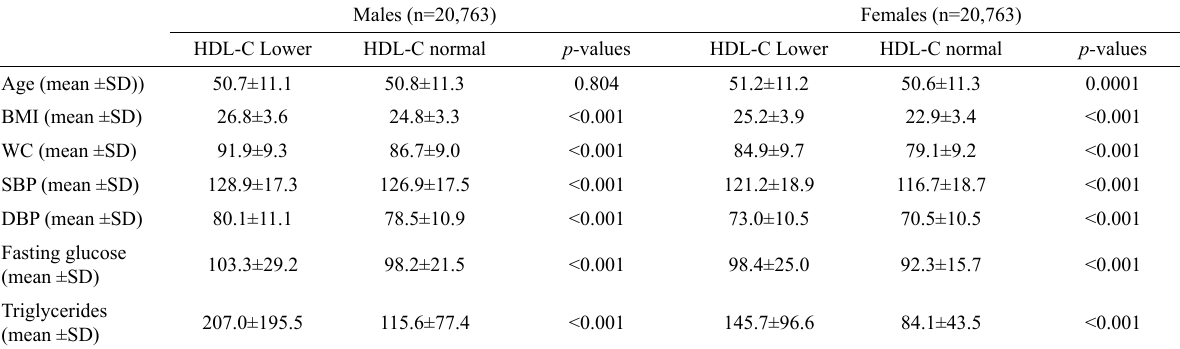
Table 1 – Relationship between low-HDL-C and basic demographic and biochemical markers.